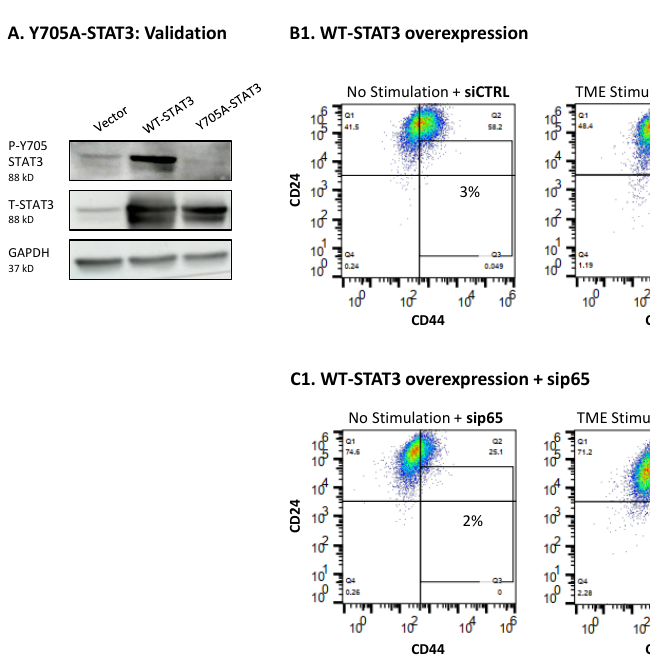
Figure 12. Upon TME Stimulation, mutated Y705A-STAT3 and p65 knock-down have additive func- tions, leading to further increased CSC enrichment in HR+/HER2 − breast cancer cells: MCF-7 cells over-expressing WT-STAT3 or STAT3 mutated in Y705 (Y705A-STAT3) were generated. ( A ) Validation of reduced Y705-STAT3 phosphorylation in Y705A-STAT3 cells, determined after cell growth in culture. ( B ) Cells expressing WT-STAT3 ( B1 ) or Y705A-STAT3 ( B2 ) were transfected with siCTRL and were exposed to TME Stimulation (concentrations as described in Figure 1), or treated by vehicle con- trol (“No Stimulation”). The contents of CSCs were determined following 96 h of TME Stimulation, as described in Figure 1. ( C ) Cells expressing WT-STAT3 ( C1 ) or Y705A-STAT3 ( C2 ) were transfected with sip65, and were analyzed similarly to the cells in Part B. The results in Parts B and C are from a representative experiment of n = 3, showing similar results. The uncropped blots are shown in Figure